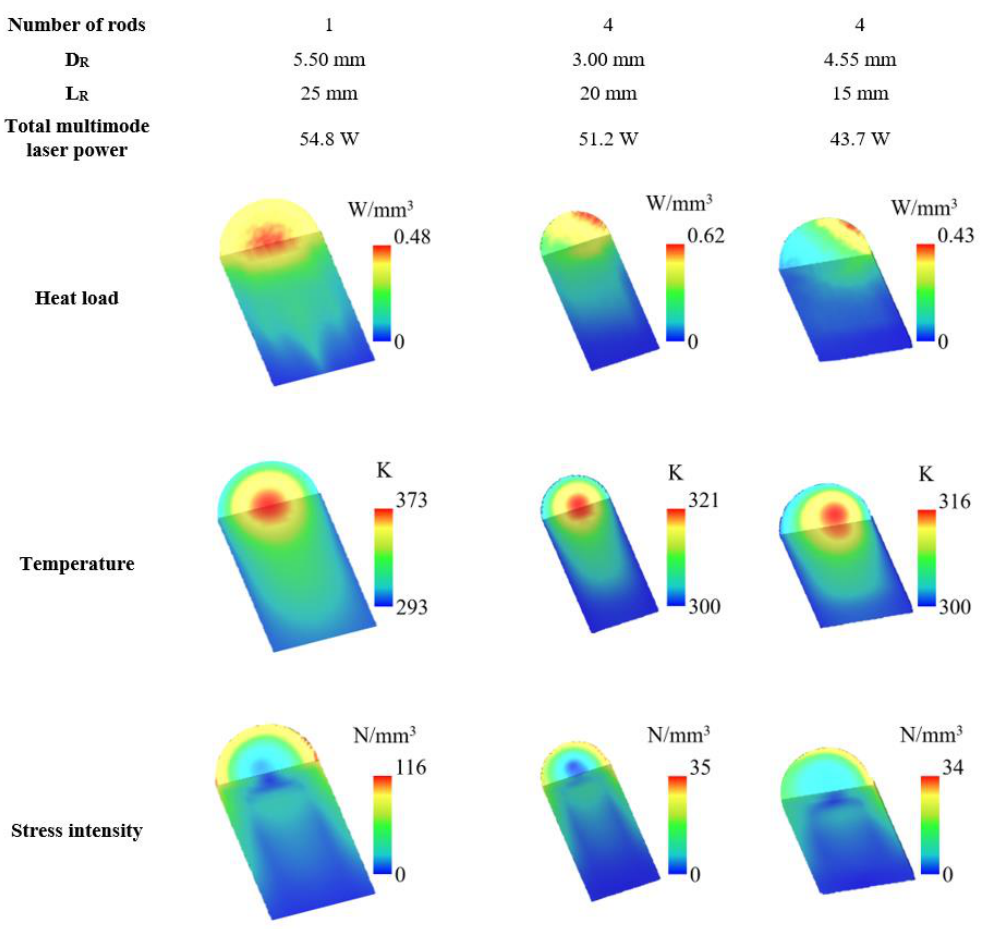
Figure 12. Numerically calculated heat load, temperature and stress intensity distributions of the 5.50 mm diameter, 25 mm length Nd:YAG rod from the single-rod scheme, and one of the four 4.55 mm diameter, 15 mm length and 3.00 mm diameter, 20 mm length Nd:YAG rods from the four-rod